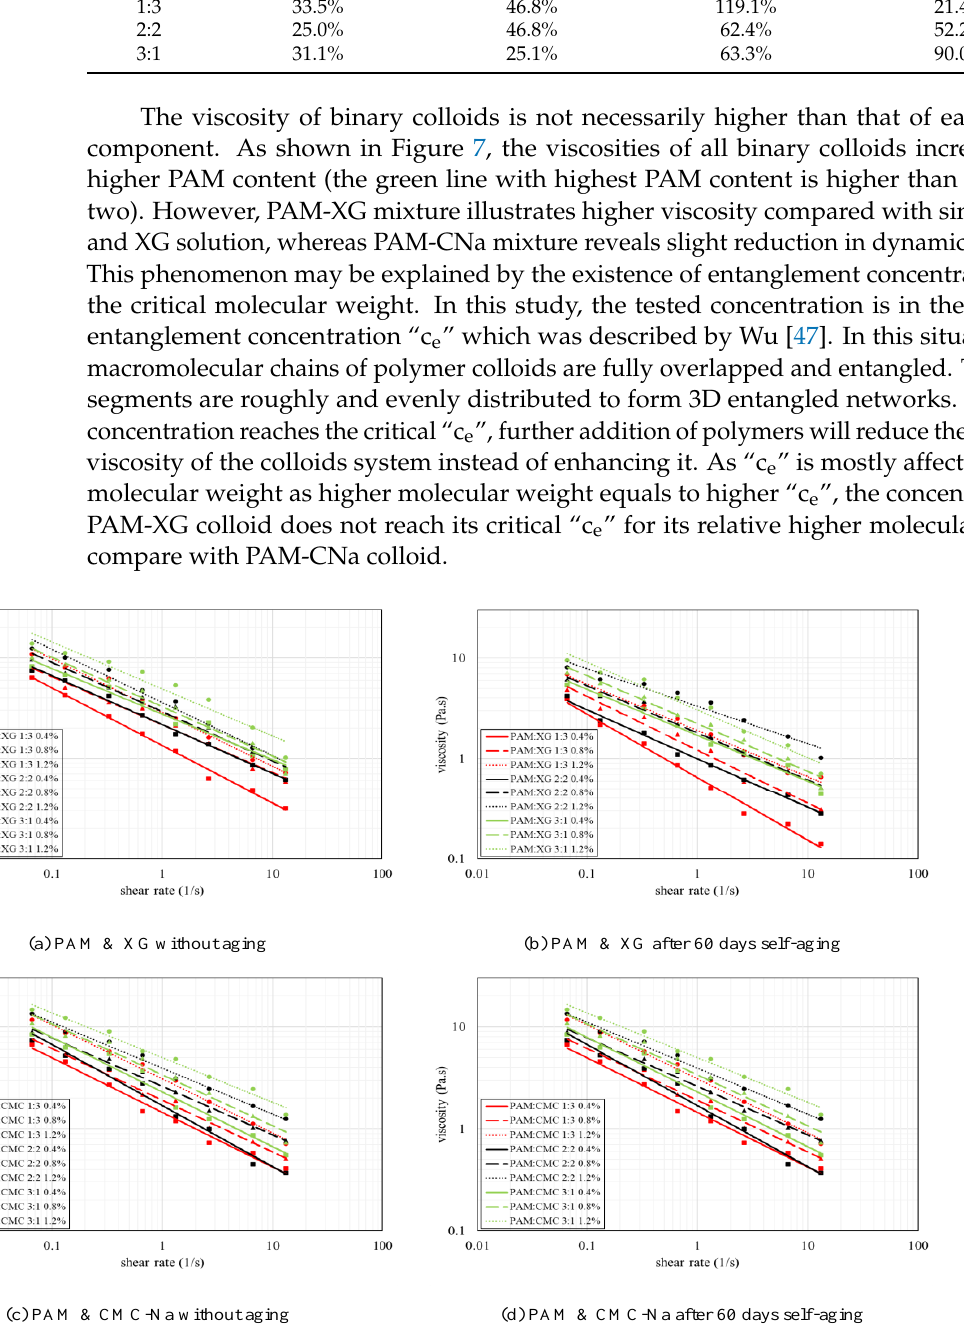
Figure 7. Dynamic viscosity of polymer mixtures at different mix ratios.